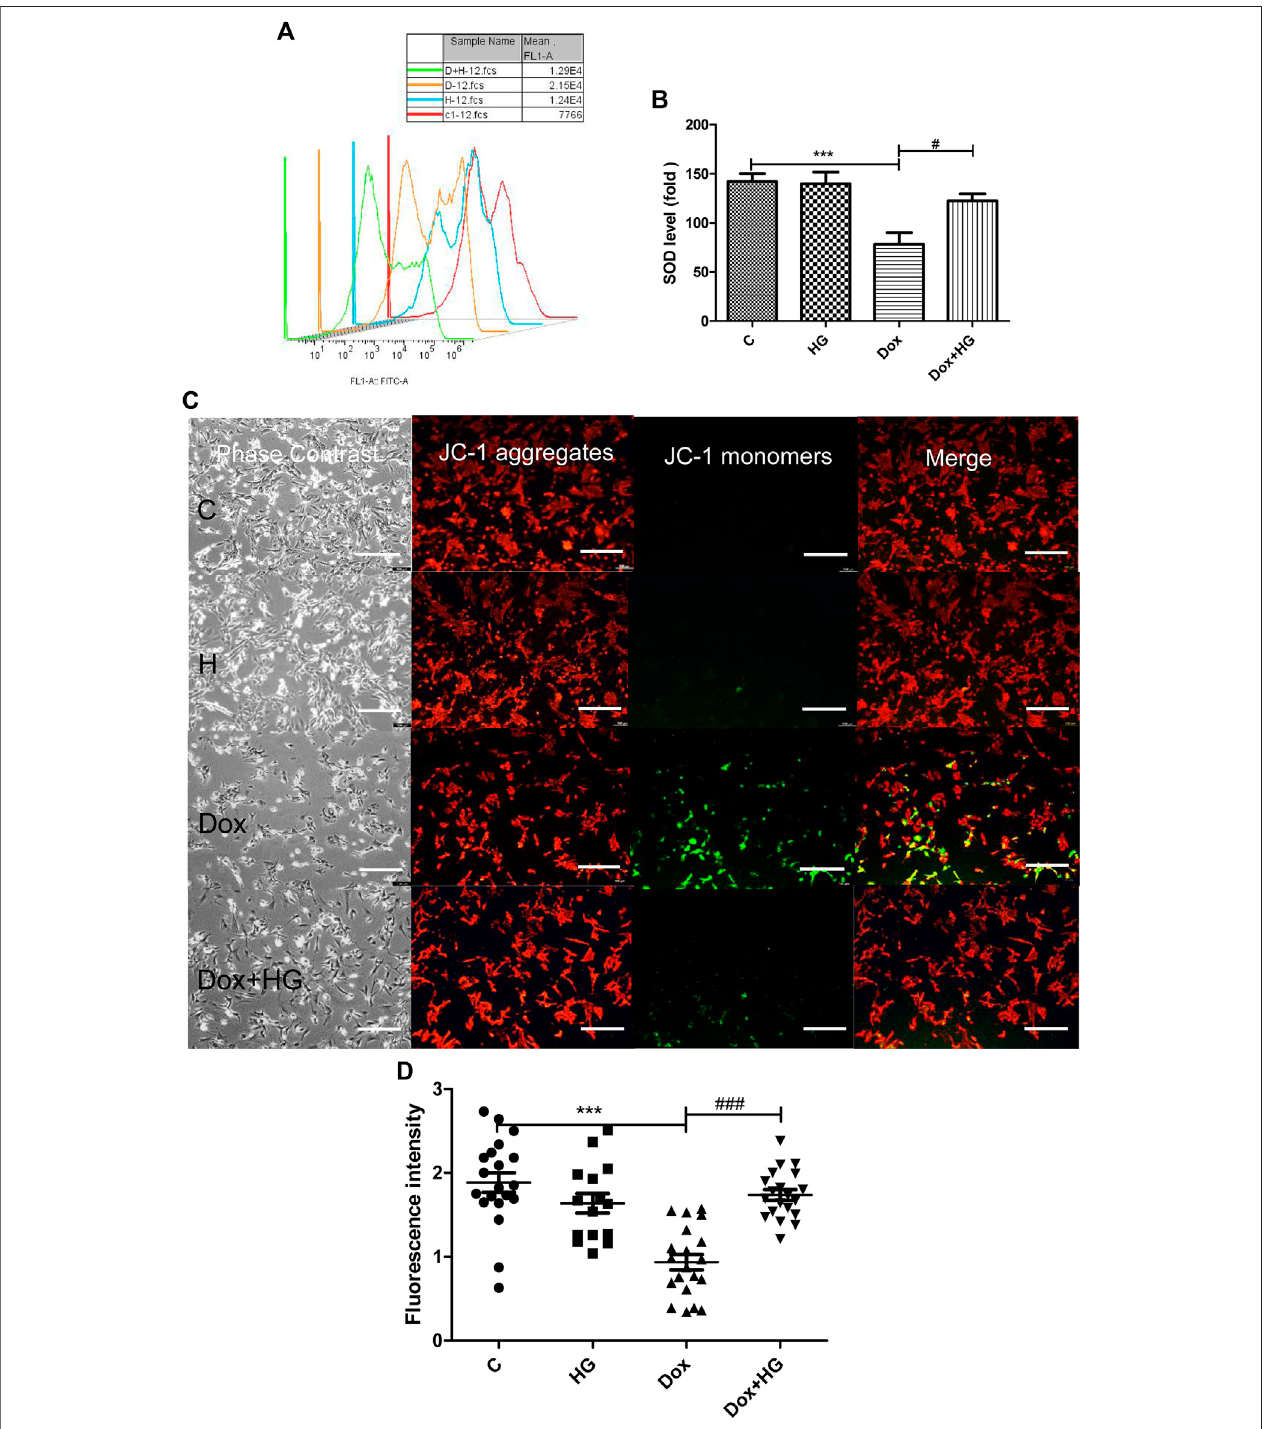
FIGURE 6 | HG alleviated DOX-induced NRVM oxidative stress injury in vitro . (A) Content of ROS activity in NRVMs. (B) Content of SOD activity in NRVMs. (C) Mitochondrial membrane potential in cardiomyocytes were detected by using the JC-1 probe. The images were recorded using a microscope (Laika) at ×40 magni fi cation. (D) Quantitative data of the JC-1 red-to-green fl uorescence intensity ratio. The aforementioned experiments were repeated more than three times. All values are presented as mean ± SEM; statistical analysis was performed using Prism 8.0 one-way ANOVA. * p < 0.05 DOX vs Control C; # p < 0.05 DOX + HG vs